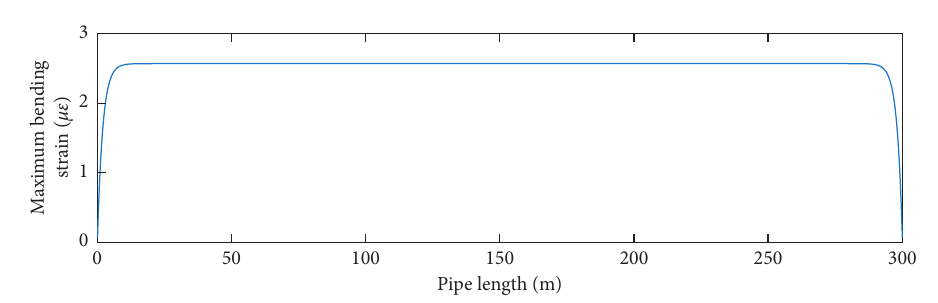
Figure 9: Maximum bending strain of straight pipe.